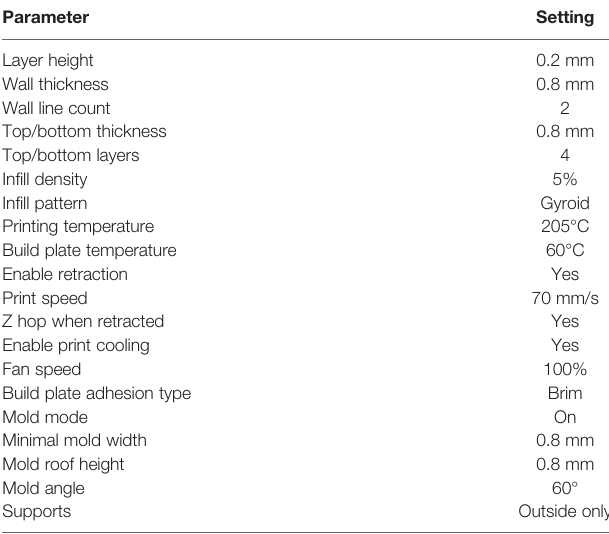
TABLE 1 | Setting of the automated Cura print pro fi le. Parameter